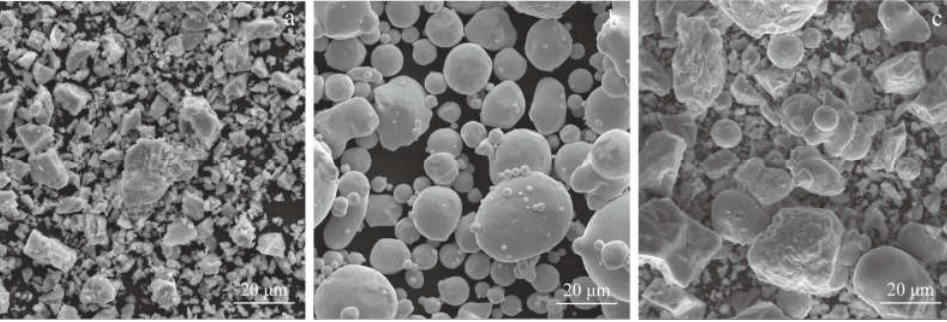
Figure 1. SEM images of the powders: ( a ) Ti powder; ( b ) Ni powder; ( c ) Ni-Ti blended powders. The reagents used in the gel system were as follows. N-octanol, hydroxyethyl methacrylate (HEMA), 1,6-hexanediol diacrylate (HDDA), tert-butyl peroxybenzoate (TBPB) and N,N-dimethylaniline (DMA) were used as solvent, organic monomer, crosslinker, initiator and catalyst, respectively, and they were all supplied by Aladdin Industrial Co.,